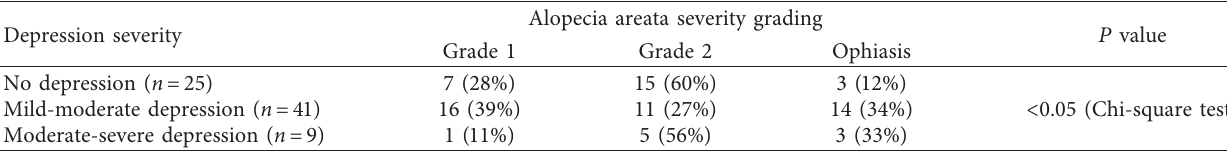
Table 2: Relation between depression and alopecia areata severity grading.